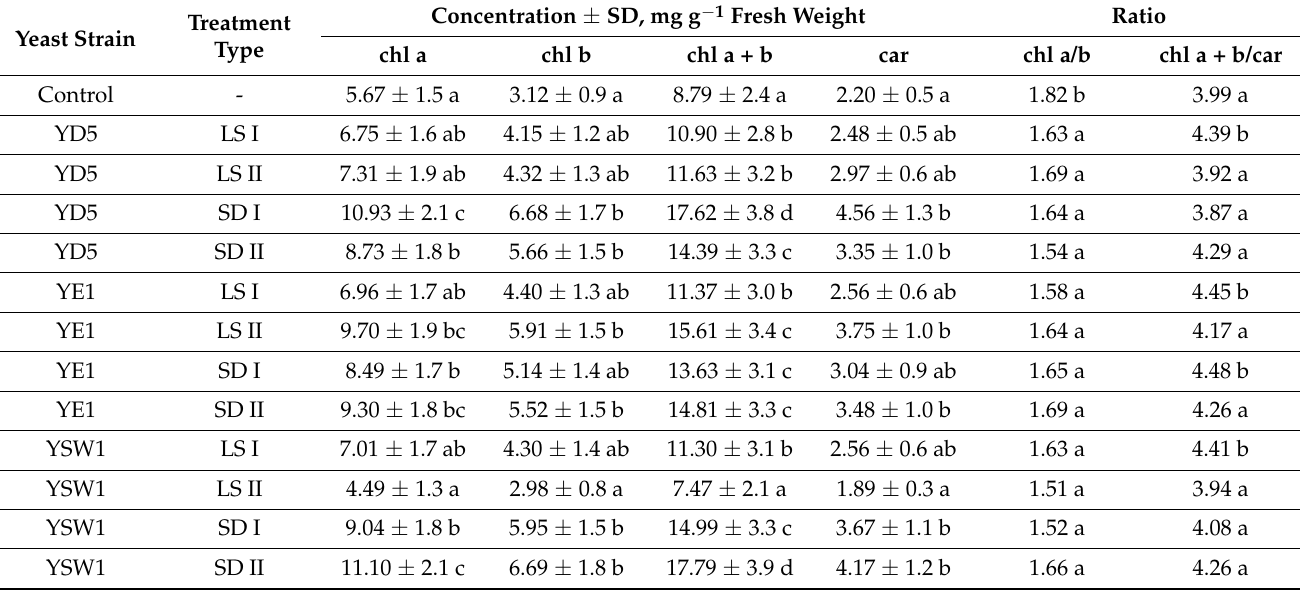
Table 6. An assay for photosynthetic pigments in experimental plants treated by soil drench (SD) and leaf spraying (LS) at 28 days after first treatment and 14 days after the second